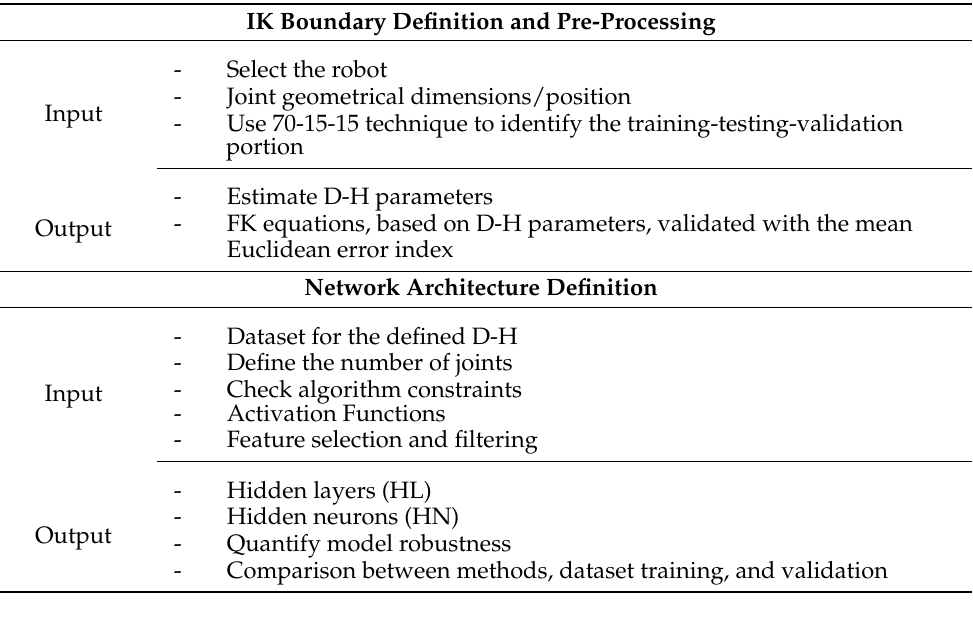
Table 1. Input/Output IK